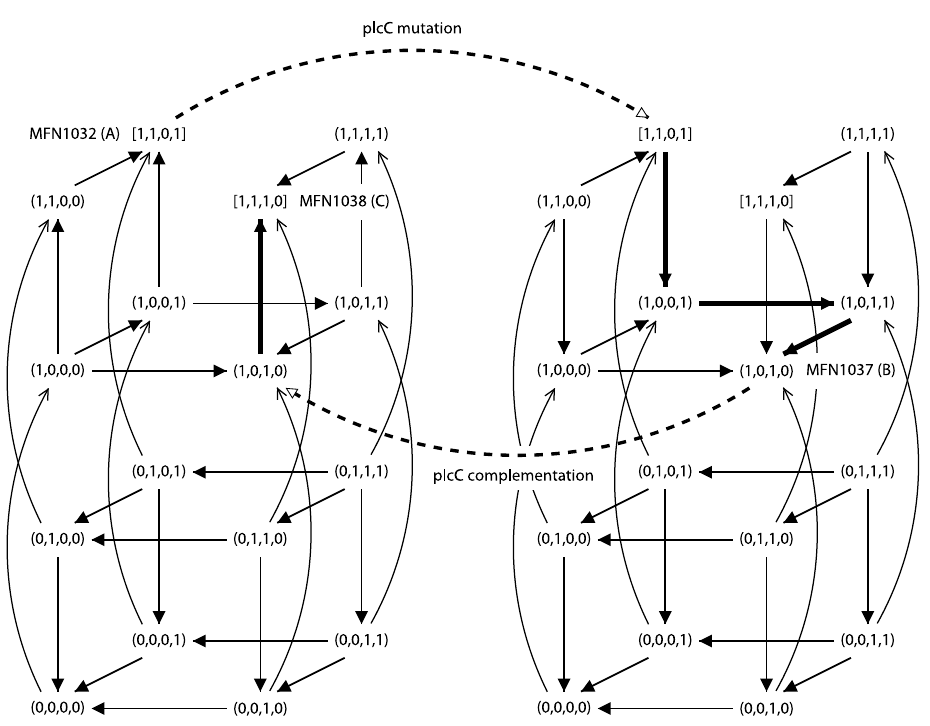
Figure 4. Illustration of property P on the consistent network of Figure 3. Asynchronous state graphs are represented in a 4D-grid, as in Figure 3. The left graph described the dynamics of network of Figure 3. The right graph described the dynamics of this network under plcC mutation. Stable states A , B and C corresponds to strains MFN1032, MFN1037 and MFN1038, respectively. Dotted arrows represent the effect of mutation or complementation in plcC . Bold lines represent trajectories followed by the systems.